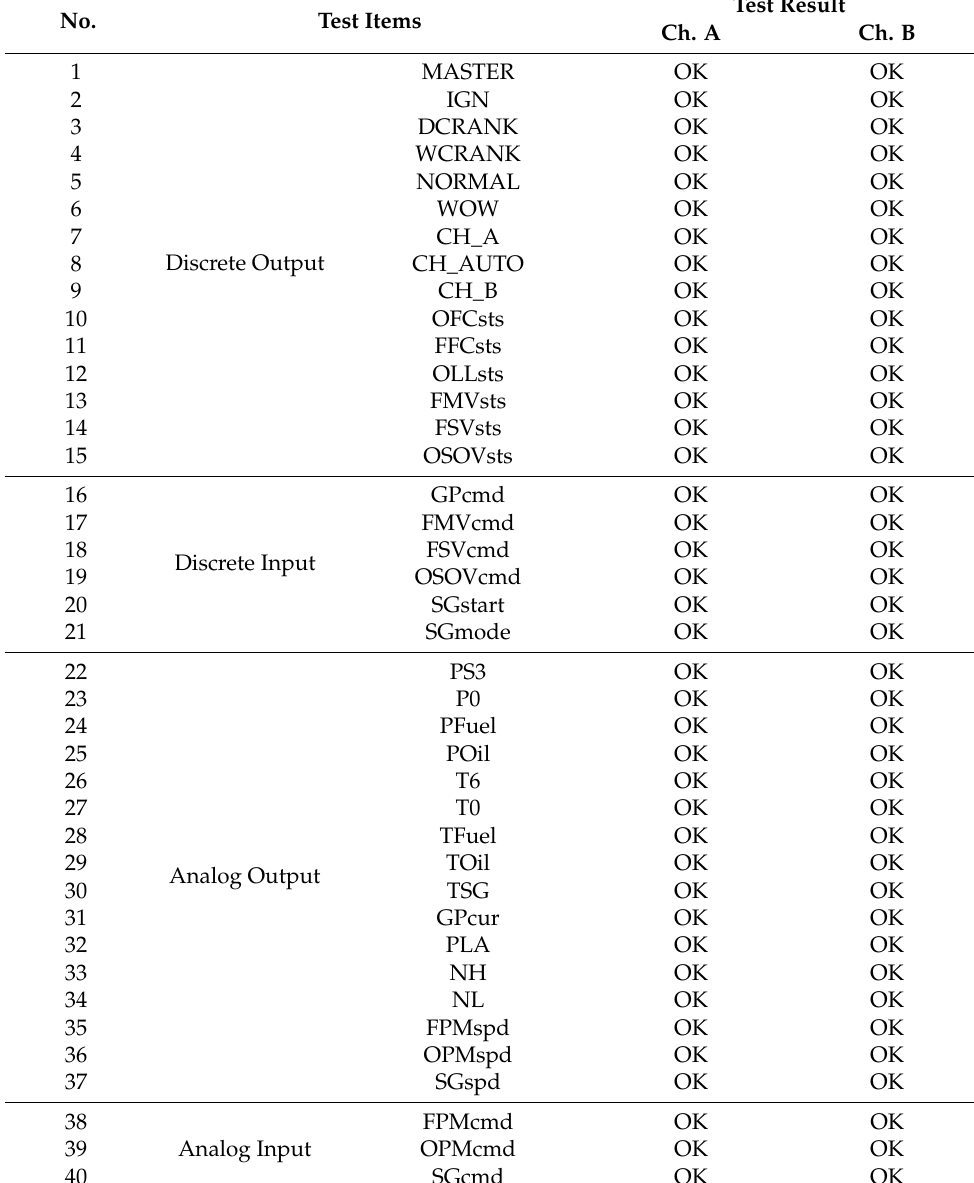
Table 6. Result of EECU test bench interface